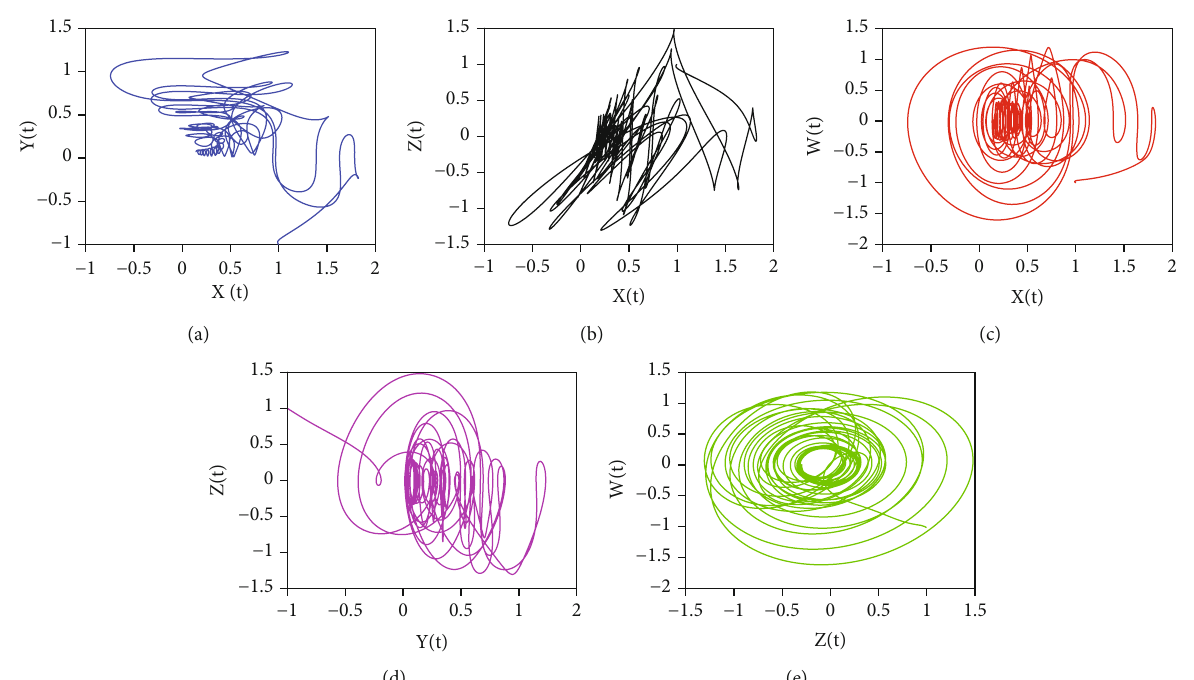
Figure 5: The behavior of di ff erent state variables of system 1 with fractional order ϖ = 0 : 99 and the parameters are considered as c = d = 2